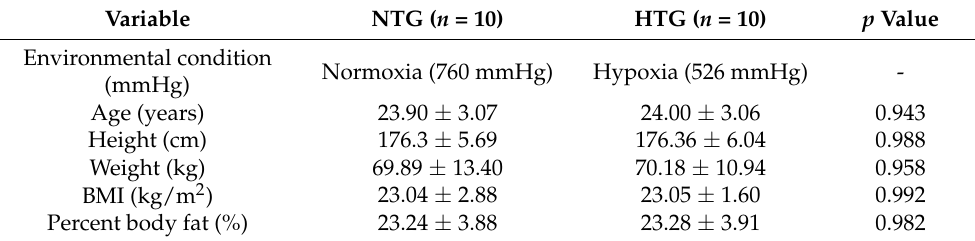
Table 1. Subjects’ characteristics.